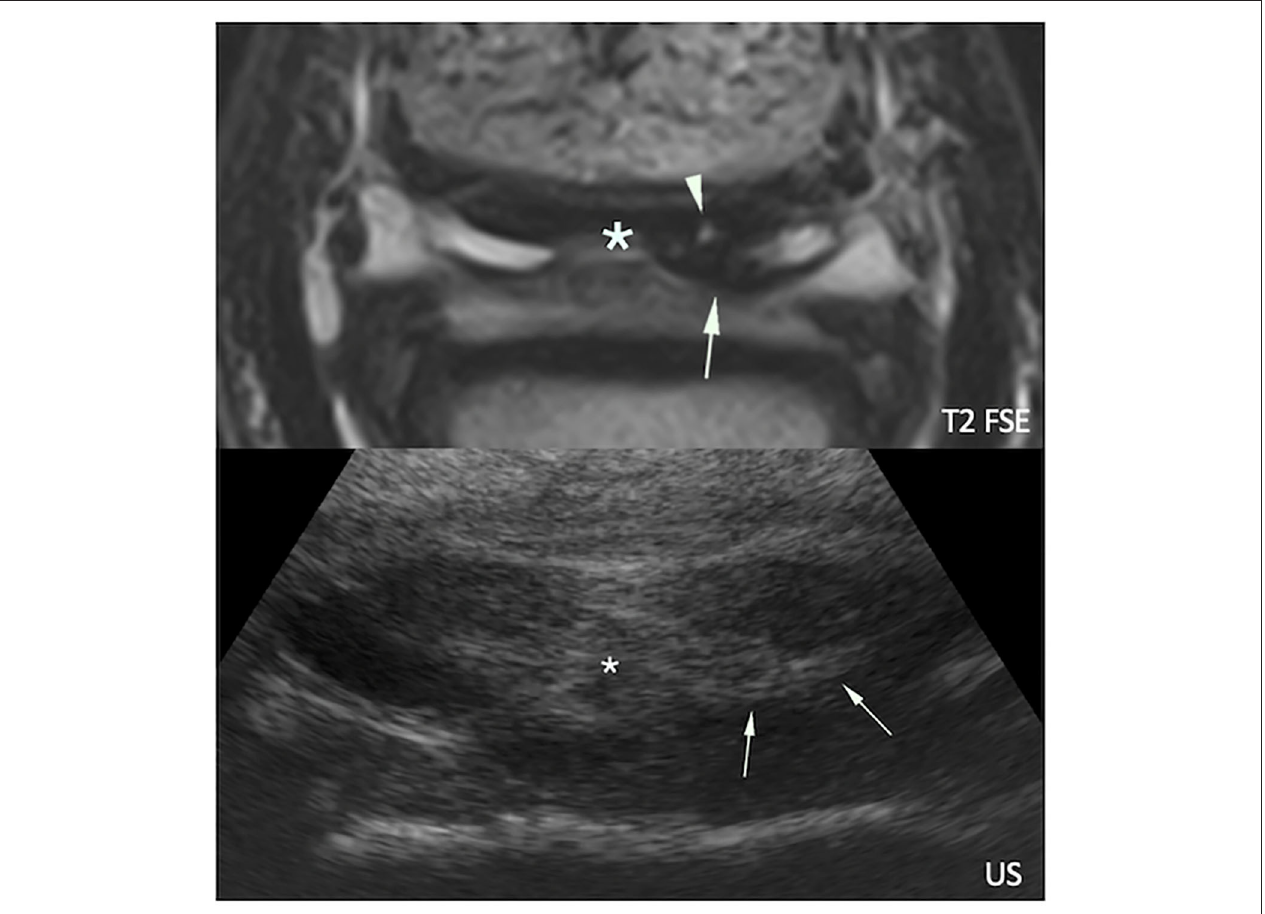
FIGURE 7 | Transverse magnetic resonance (MR, top) and ultrasonographic (bottom) images of a right front foot focused on the deep digital flexor tendon (DDFT) and navicular bursa: lateral is to the right and dorsal to the bottom. The navicular bursa is distended by a moderate amount of fluid, and there is marked thickening of the mesotendon (asterisks). Proliferated soft tissue material (arrows) is visible adjacent to a MR hyperintense dorsal lesion of the DDFT lateral lobe